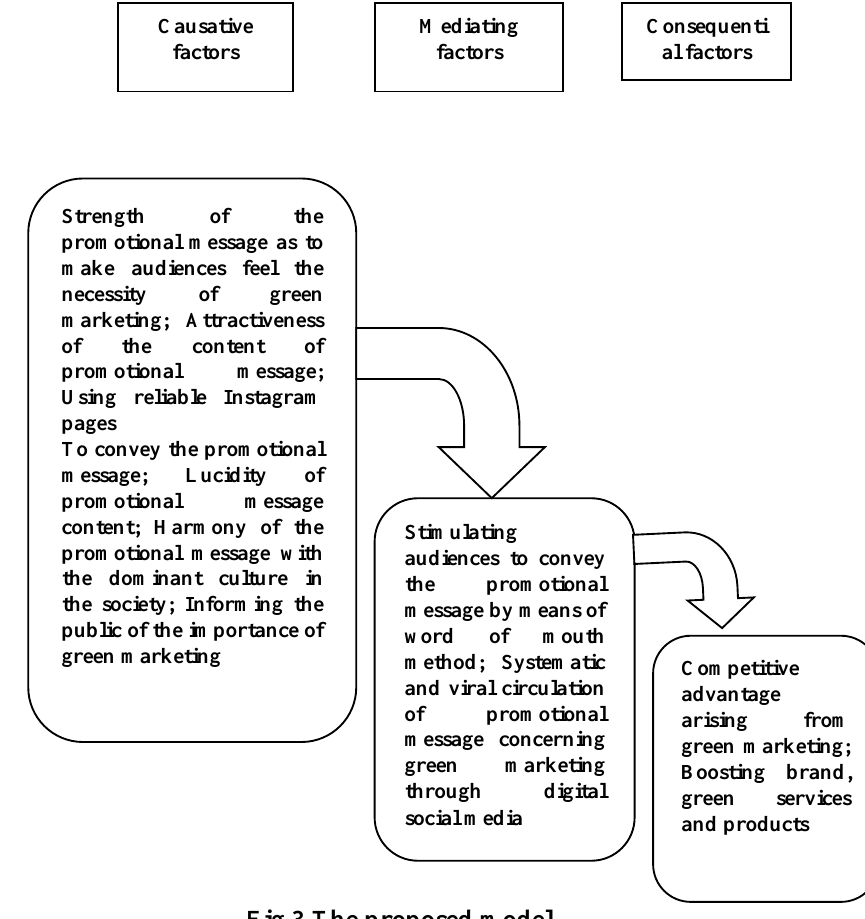
Fig.3.The proposed